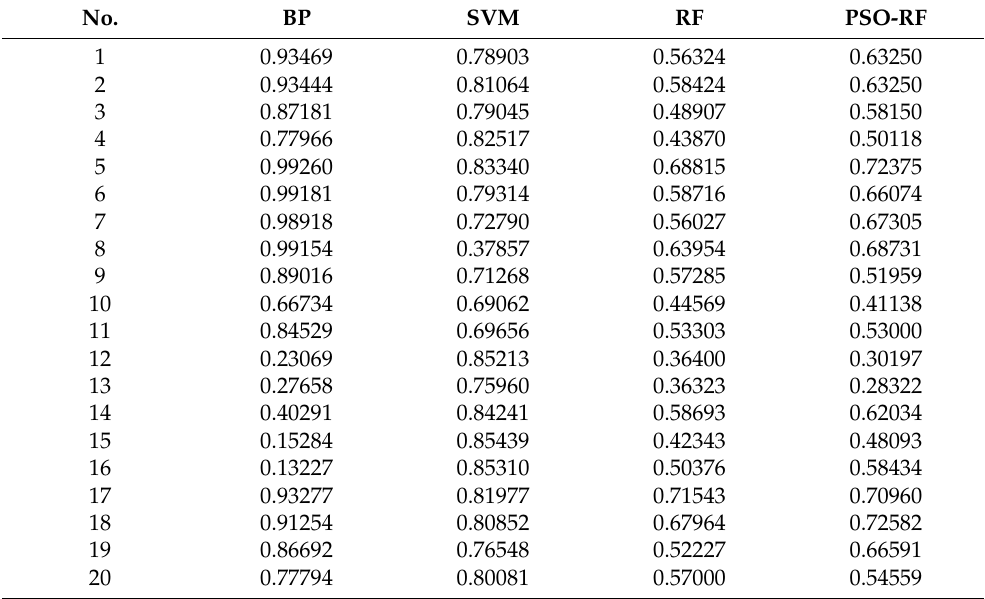
Table 6. The landslide susceptibility probabilities of some grid cells calculated by the four models. No.